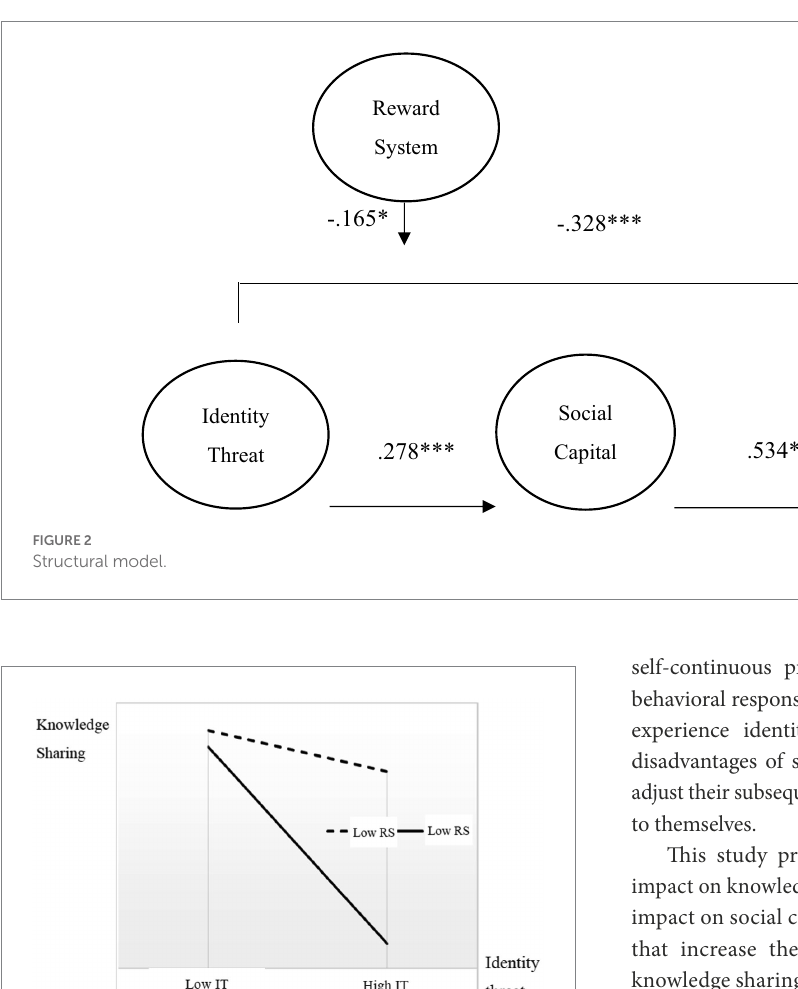
FIGURE 3 Interaction